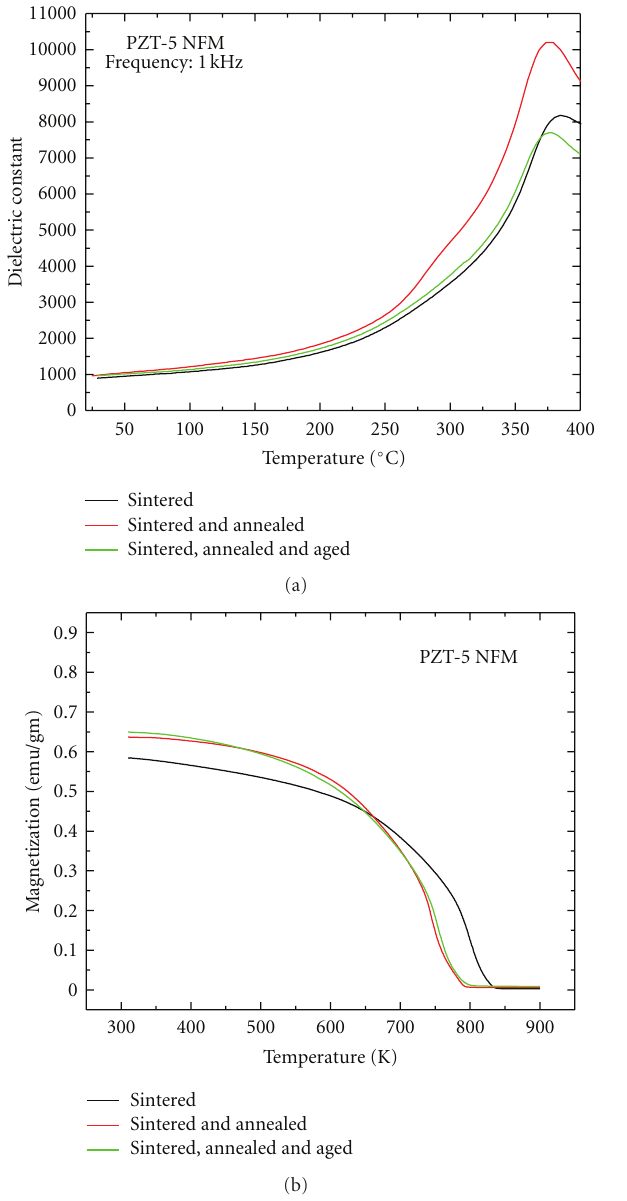
Figure 12: Temperature-dependent ferroelectric and ferromagnetic property of PZT-5 NFM composite. Temperature dependent, (a) dielectric constant, (b) saturation magnetization.